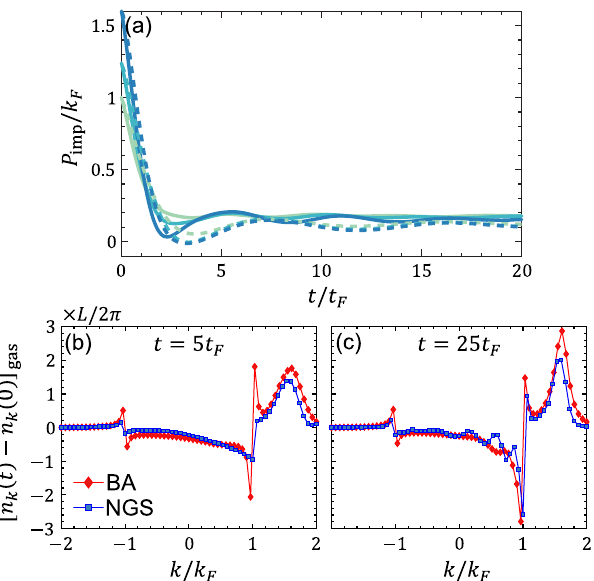
FIG. 7. Comparison of out-of-equilibrium correlations. (a) Evo- lution of the impurity momentum for three different initial con- ditions. Solid curves represent our variational simulations and dashed curves show the BA results adopted from Ref. [49]. Note (i) damped quantum flutter oscillations for intermediate times and (ii) saturation of the impurity momentum at t → ∞ . The non- Gaussian approach well captures the initial dynamics and satu- ration,butthediscrepancyatintermediatetimesisclear.Parameters used are γ ¼ 10 , N ¼ 51 , Λ ¼ 10 k . (b),(c) Momentum distribu- F tion function of the host-gas particles at t ¼ 5 t (b) and t ¼ 25 t F F (c). Thesegraphs demonstrate that dynamical NGS correlations are in good agreement with those of the BA [49]. Parameters used are